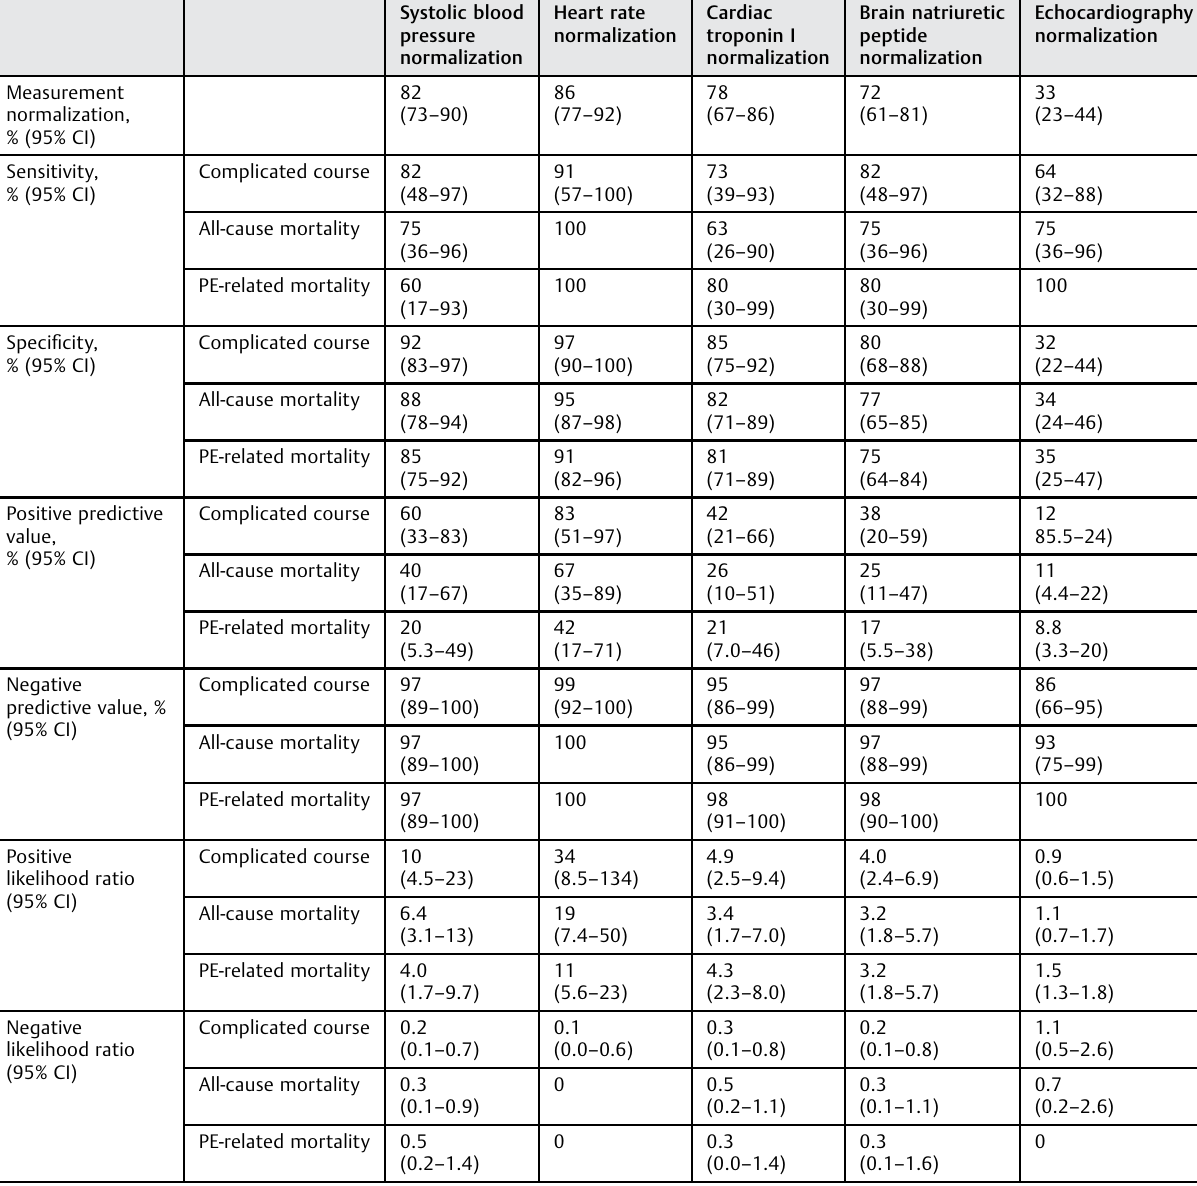
Table 3 Characteristics of tests performed 48 hours after PE diagnosis for predicting 30-day adverse